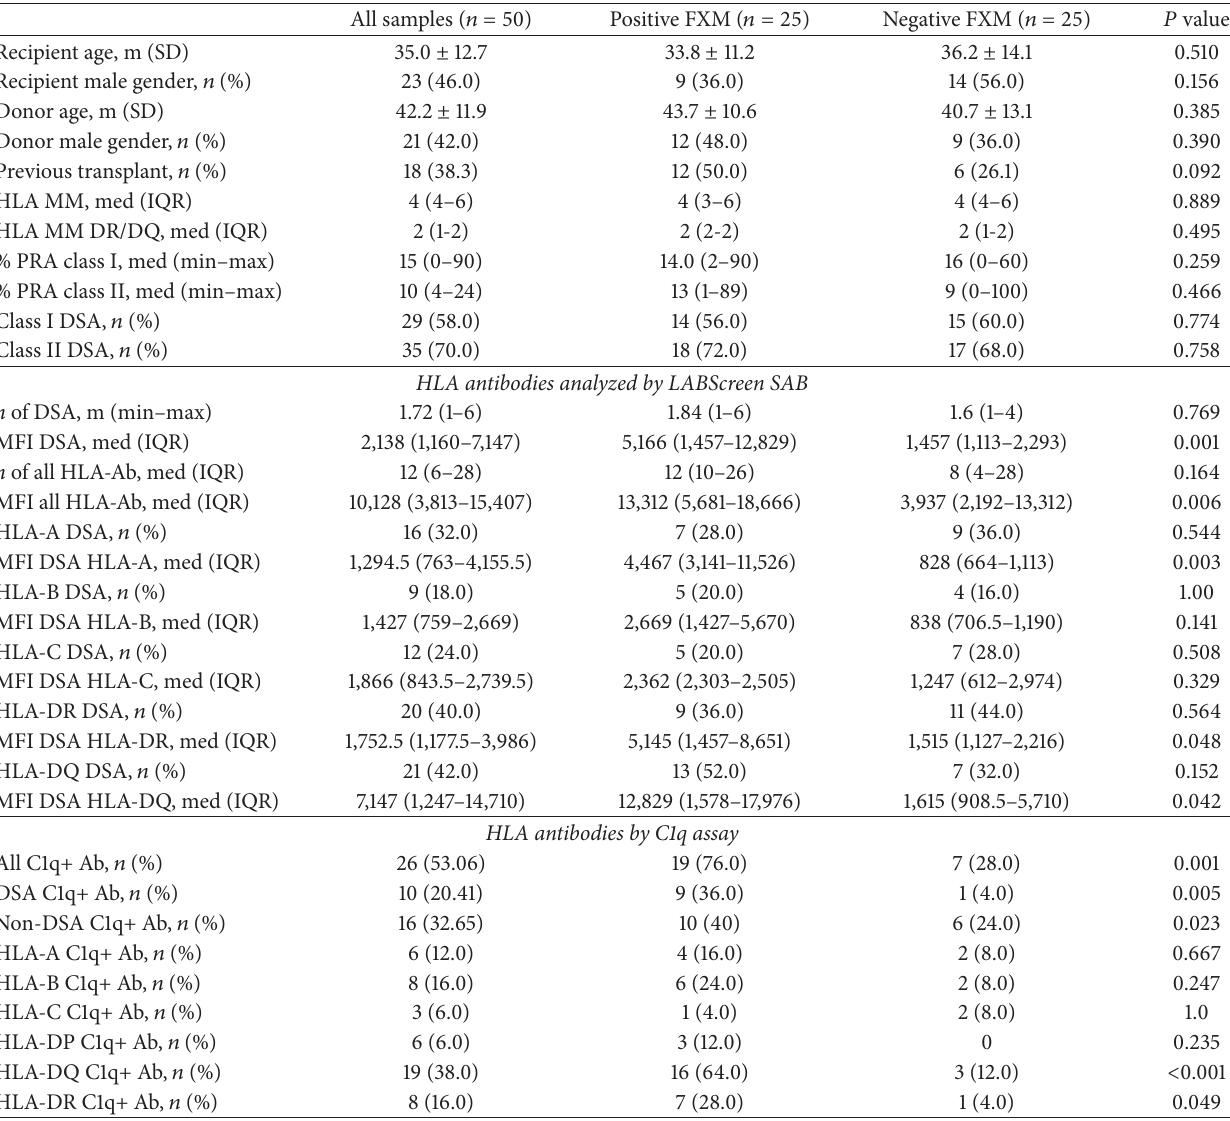
Table 1: Factors associated with a positive FXM. DSA determinations are expressed according to the LABScreen SAB results. MM =